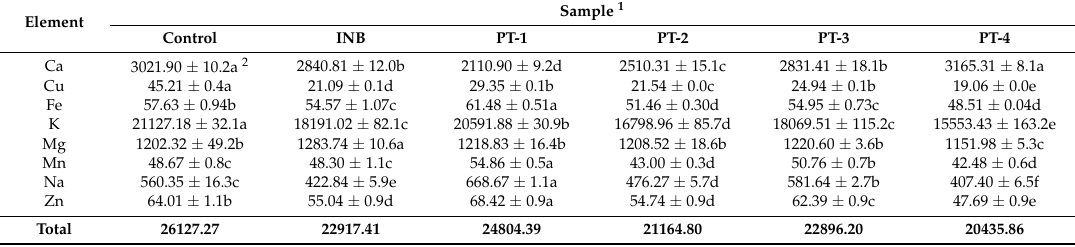
1 Samples are defined in Table 1. 2 Values are expressed as mean ± standard deviation of two replicates. Values followed by different letters (a, b, c, d, e, and f) in the same row are significantly different ( p < 0.05, ANOVA, Tukey test).